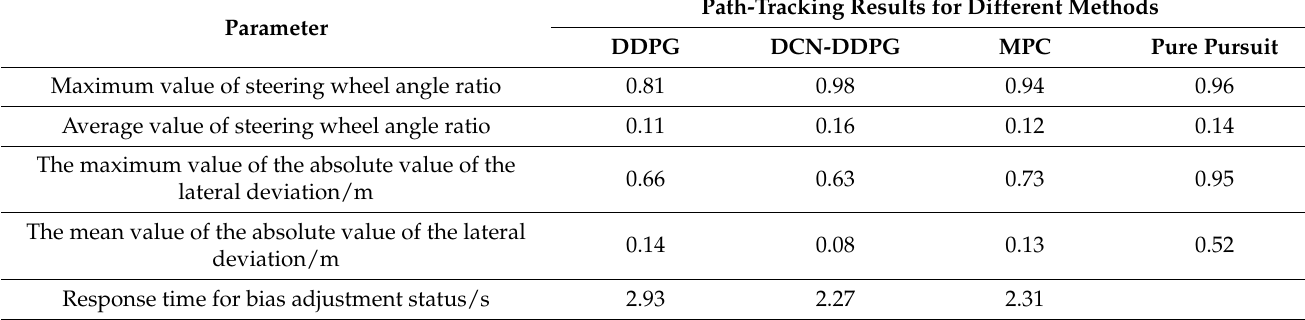
Table 5. Path-tracking results